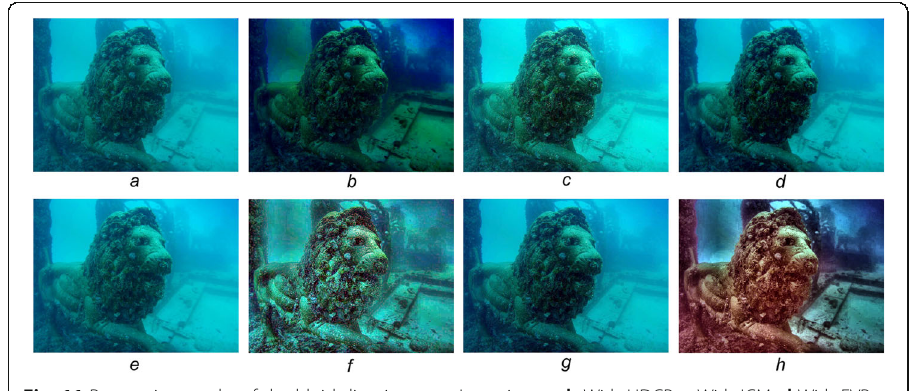
Fig. 11 Restoration results of the bluish lion image. a Input image. b With UDCP. c With ICM. d With FVR. e With DCP. f With ERD. g With IBLA. h With the proposed algorithm